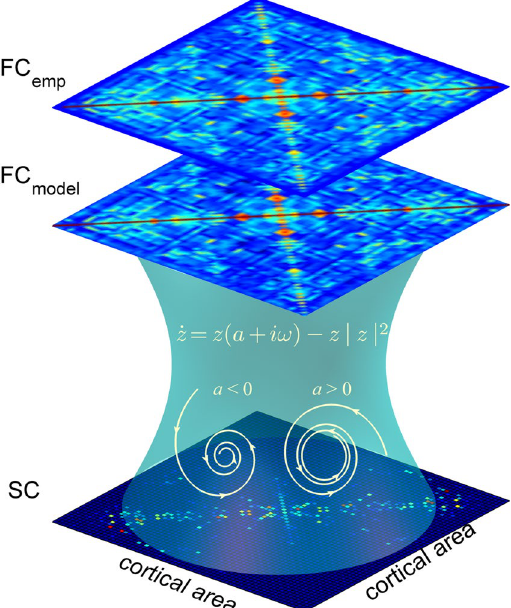
Figure 2. Whole-brain model linking anatomical connections and FC. The anatomical connectivity data were obtained using DTI averaged over a group of healthy participants. Using the AAL 90 parcellation we obtained a structural connectivity (SC) matrix linking 90 cortical and subcortical nodes with each other anatomically. Based on this matrix, a Hopf whole-brain computational model is built which simulates the resting activity of the 90 coupled brain areas. The simulated functional connectivity matrix (FC model ) is then fitted to the empirical functional connectivity matrix (FC emp ) for different model parameter combinations using the Euclidean distance between the values of FC model and FC emp (see Methods ). With this framework the model parameter space can be explored in order to find the optimal parameter combination for each brain